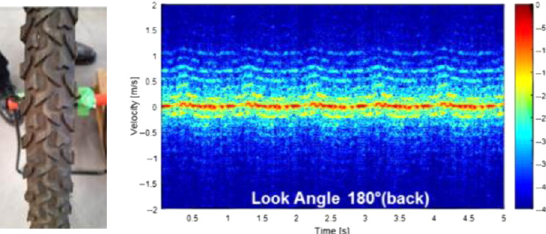
Figure 21 Micro-Doppler measurement of rotating surrogate wheel from